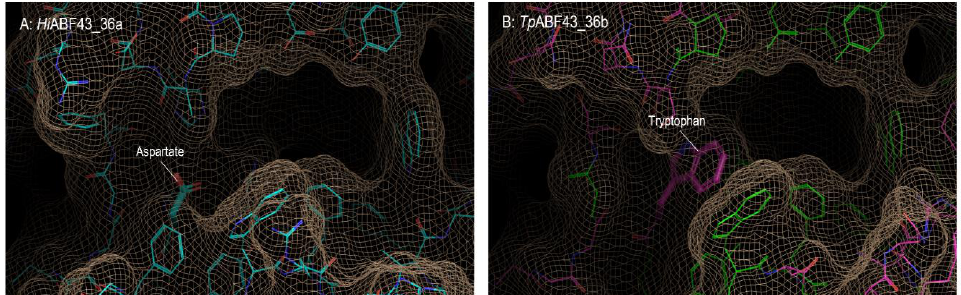
Figure 2. Structures of the active sites of ( A ) Hi ABF43_36a and ( B ) Tp ABF43_36b homology modeled on the Hi ABF43_36a chain (PDB:3ZXJ_B). In panel B, green lines show residues that are identical to amino acids present in Hi ABF43_36a shown in panel A, pink lines show residues that are different. Obviously, a single amino acid position in a protein never solely results in clustering. Based on the crystal structure of Hi ABF43_36a (PDB:3ZXJ_B), the fungal